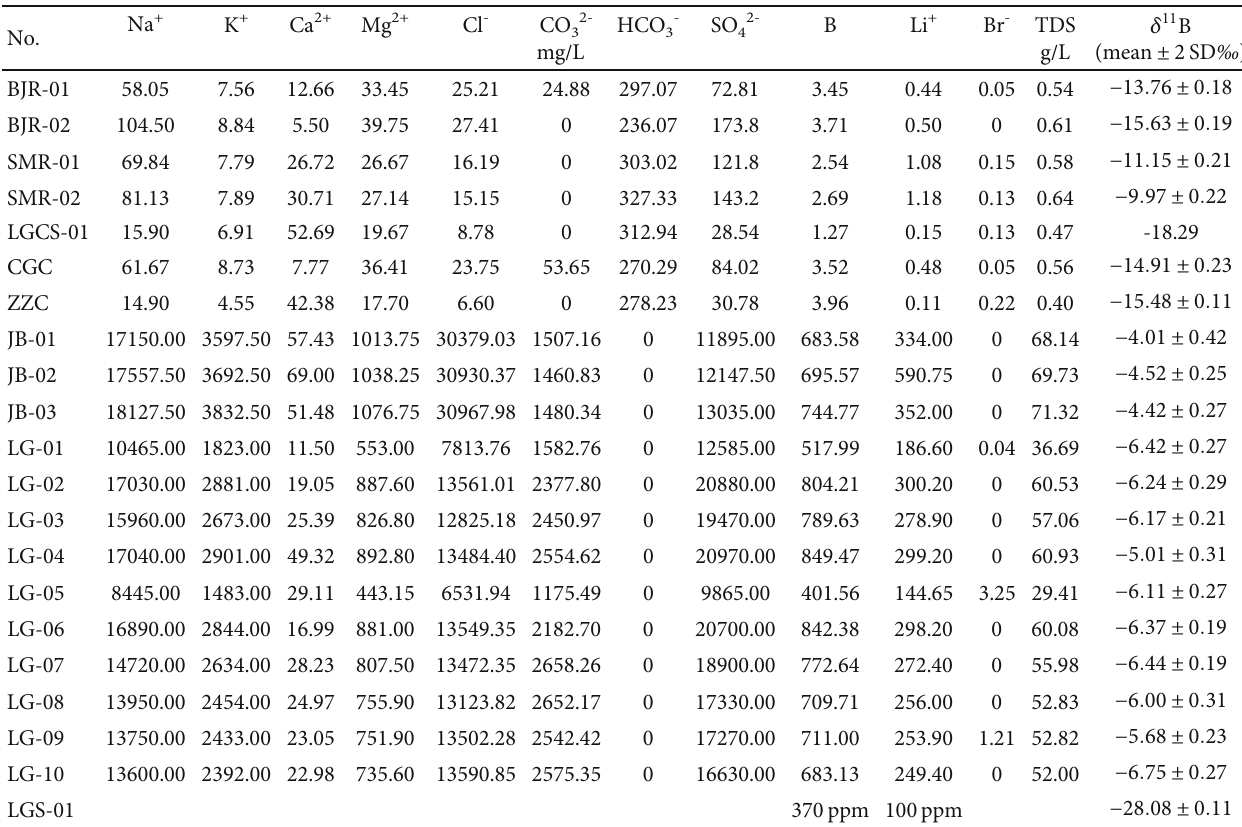
Table 1: Field sample collection, description, and measurement of temperature ( T ), pH, and density for di ff erent sample types. Na + No.